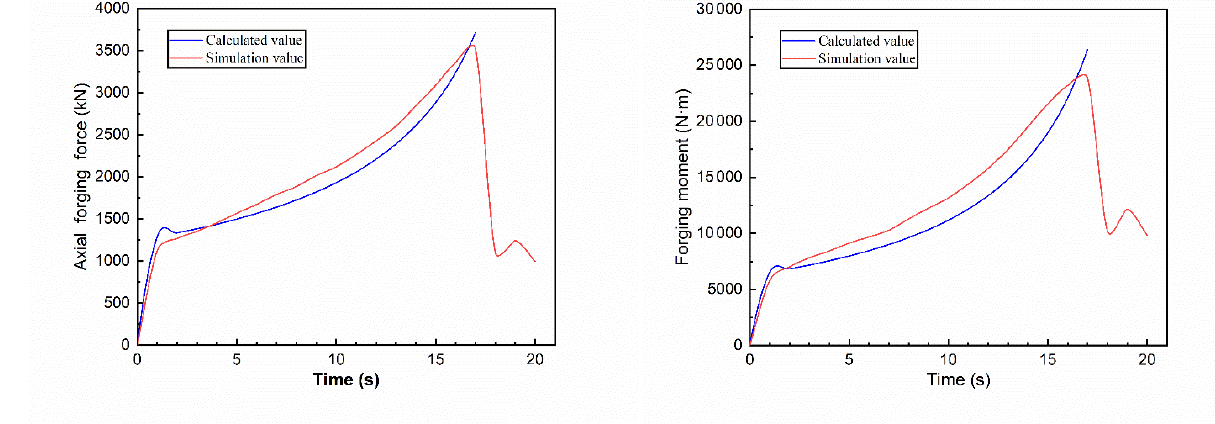
Figure 15. Comparison of force and power parameters between theoretical calculation and simulation.